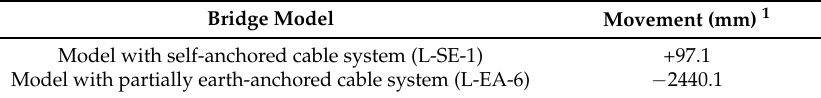
Table 5. Movement caused by removal of the longitudinal restraints in set back.